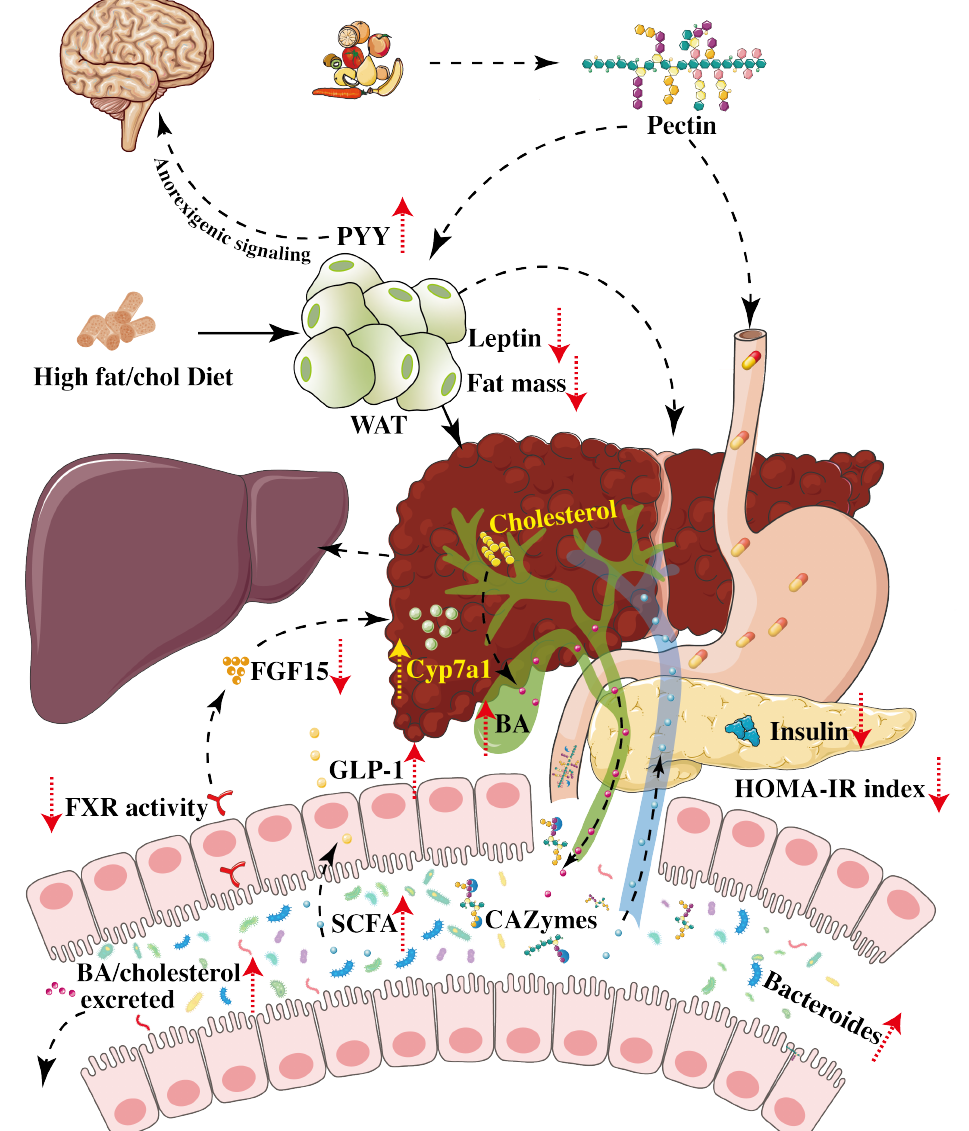
Figure 2. Graphical summary of mechanisms involved in pectin-induced changes in non-alcoholic fatty liver disease (NAFLD). High-fat and high-cholesterol diets lead to disorders of adipose tissue metabolism, inflammation, etc., thereby participating in liver damage. Complex polysaccharides of pectin are broken-down by CAZymes expressed by gut bacteria to make pectin work. Glucose homeostasis was improved by decreasing the plasma insulin concentration and HOMA-IR index and improving WAT insulin and leptin resistance associated with a decrease in plasma leptin and an increase in plasma PYY that induces anorexigenic signaling to the brain. Pectin can also decrease fat mass in WAT. Pectin increases Bacteroides and SCFA, but decreases FXR level in the intestine, induces a subsequent lower FGF15, and increases hepatic expression of Cyp7a1, which promotes the conversion of cholesterol to BA. The dotted line represents the pectin treatment process; the solid line represents the liver injury process. Abbreviations: BA, bile acid; CAZymes, carbohydrate active enzymes; Cyp7a1, cholesterol 7 α -hydroxylase 1; FGF15, fibroblast growth factor 15; FXR, farnesoid X receptor; GLP-1, glucagon-like peptide 1; HOMA-IR index, homeostatic model assessment for insulin resistance index; PYY, peptide YY; SCFA, short-chain fatty acids; WAT, white adipose